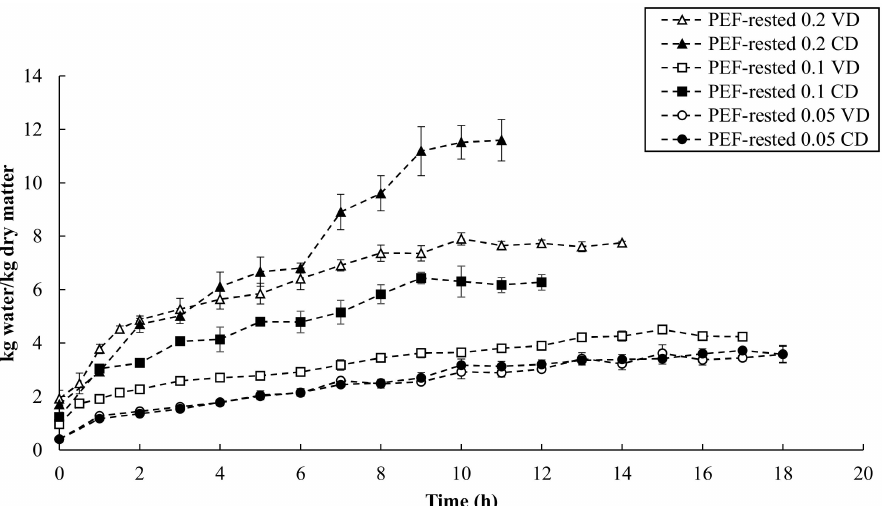
Figure 3. Rehydration curves of PEF-rested Thai basil leaf samples dried with convective drying (closed symbols) and vacuum drying (open symbols). Samples were dried to the MR of 0.2 (triangles), 0.1 (squares), and 0.05 (circles). Reported are average values of three measurements. Error bars represent the standard deviation of the